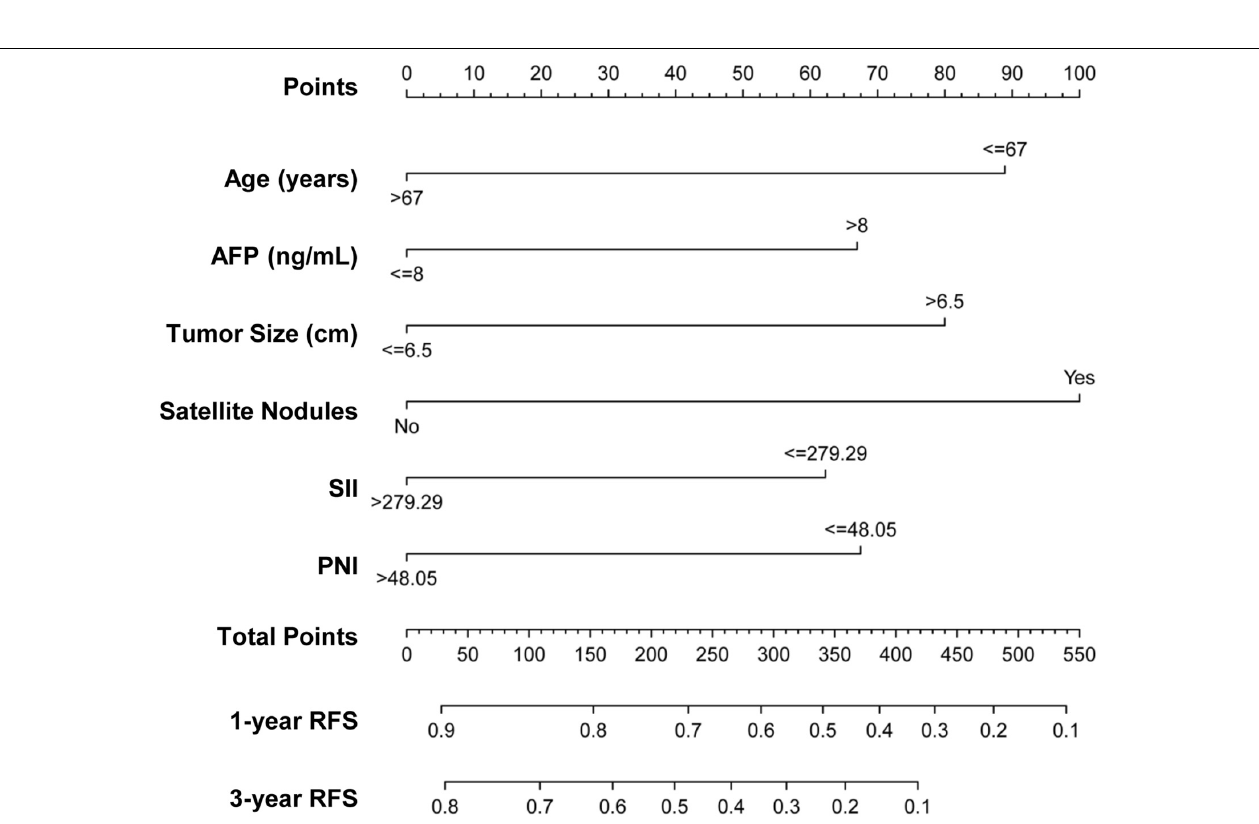
FIGURE 2 | Nomogram predicting 1- and 3-year RFS probabilities of patients with HCC. Each risk factor was assigned a point according to the nomogram. The exact values of each factor are age (0, 89 points), AFP (0, 67 points), tumor size (0, 80 points), satellite nodules (0, 100 points), SII (0, 62 points), and PNI (0, 68 points). The total points were obtained by adding the points of all risk factors. Then, the 1- and 3-year RFS could be predicted based on the total points.